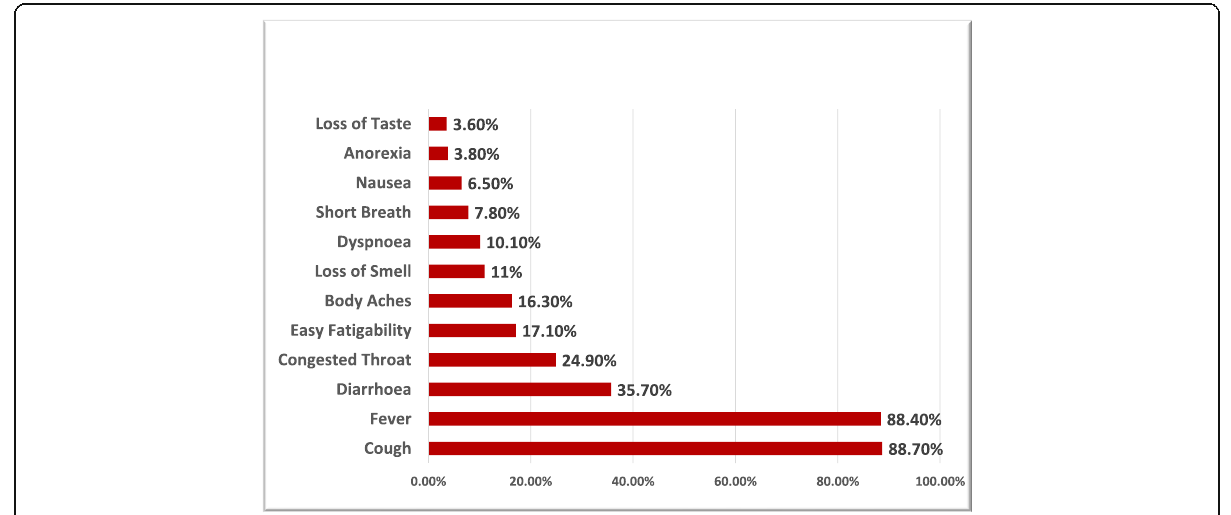
Fig. 6 Prevalence of clinical symptoms among the study patient ’ s